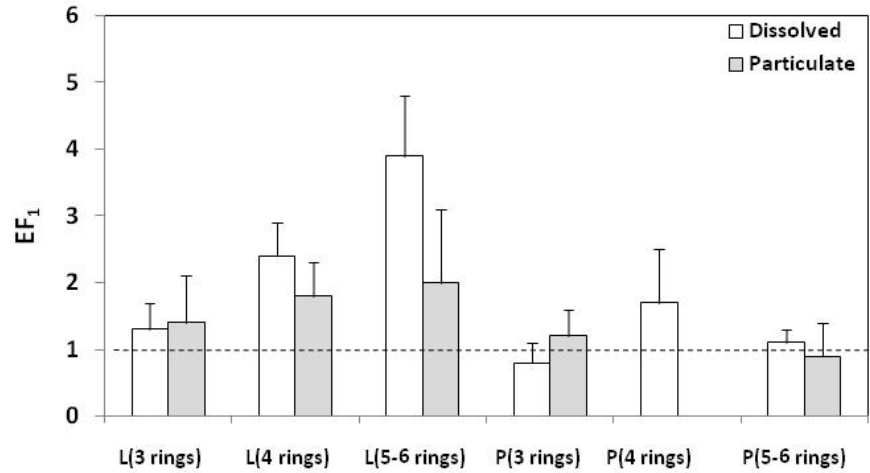
Figure 5. Average enrichment factors (EF 1 ) of 3, 4, and 5–6 rings PAHs, for dissolved and particulate phases, at the sampling sites of Loutropyrgos (L) and Pahi of Megara (P).